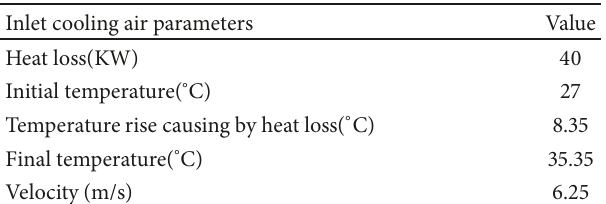
Table 1: The inlet cooling air parameters for an actual reactor support [22].